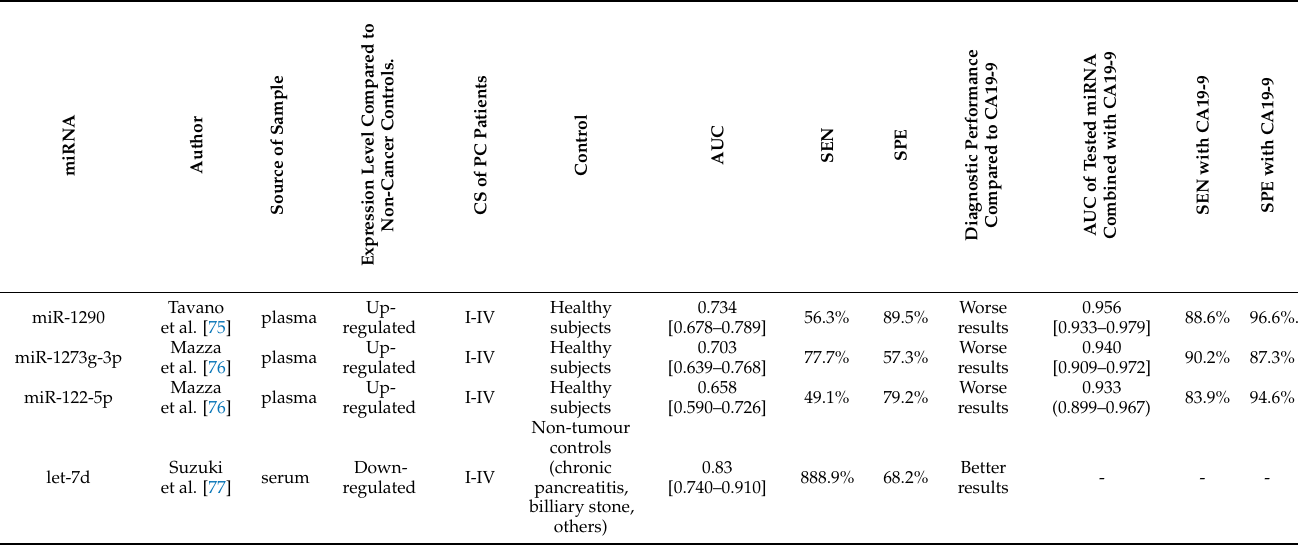
Table 1. Diagnostic performance of single miRNAs using the ddPCR method for expression